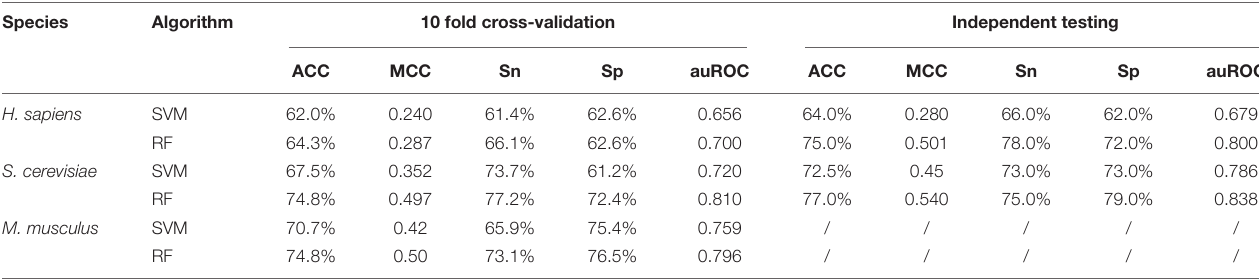
TABLE 2 | Cross-validation and independent testing scores of two different classifiers for three species. Species Algorithm